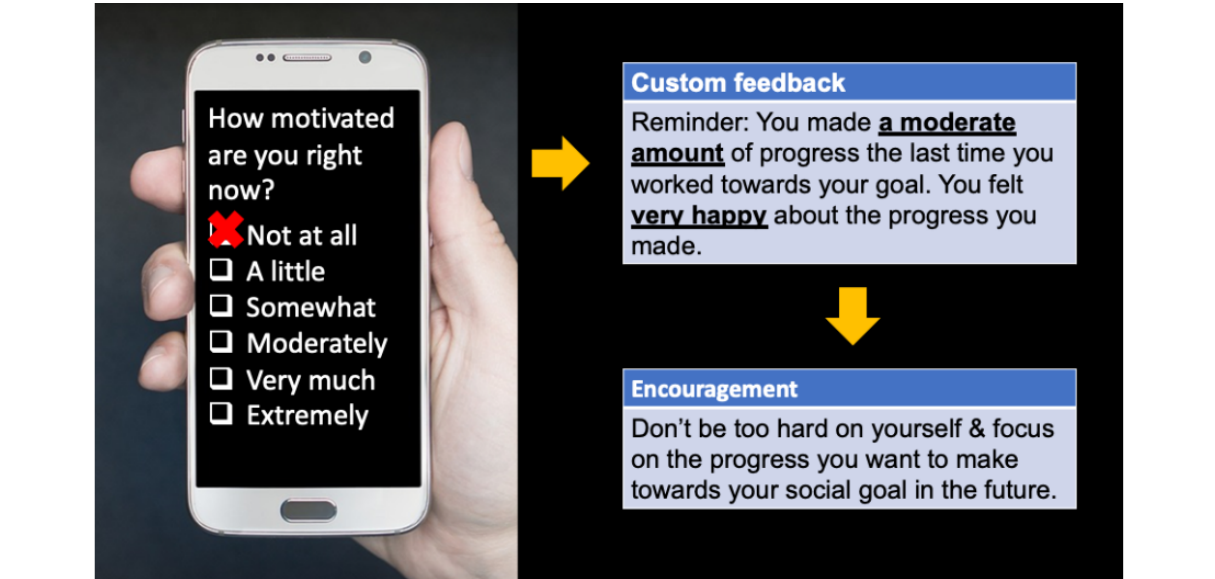
Figure 1. Motivation and Skills Support app content: feedback and validation and encouragement to address social motivation